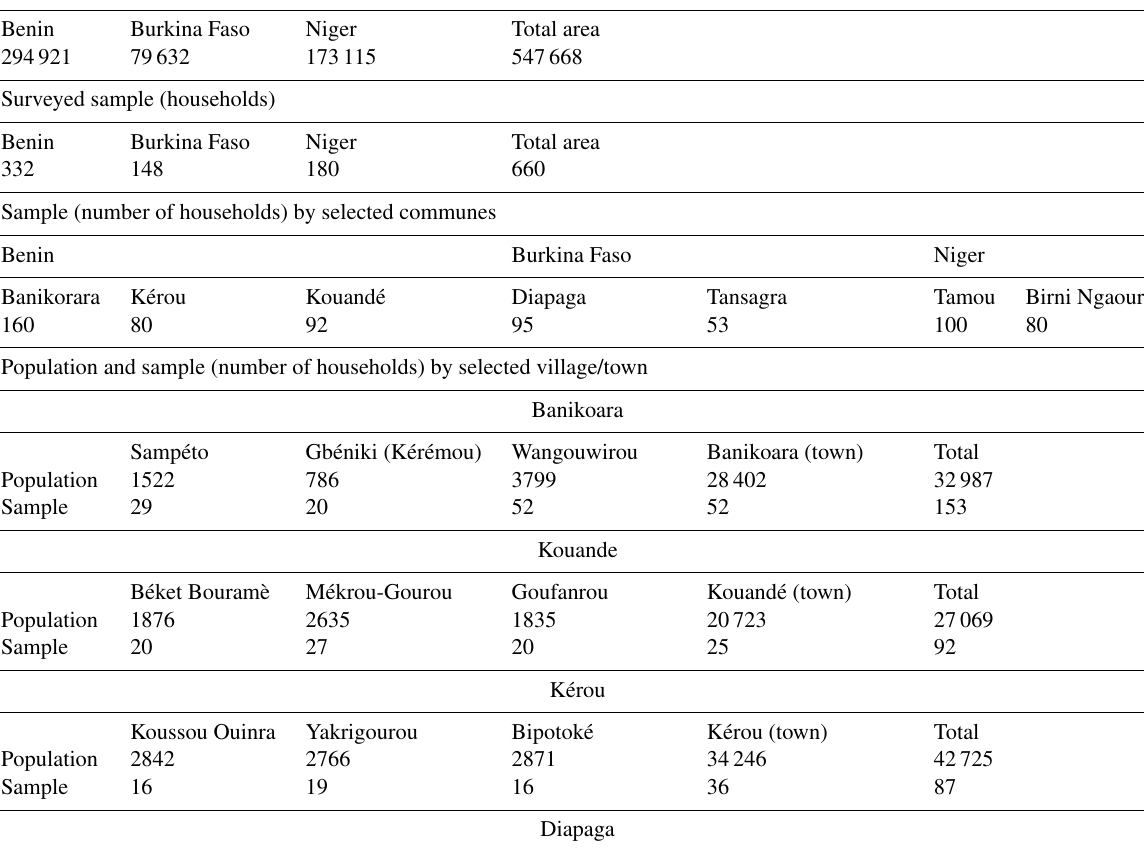
Table 1. Sample and population of the survey area. Population of the Mékrou area of